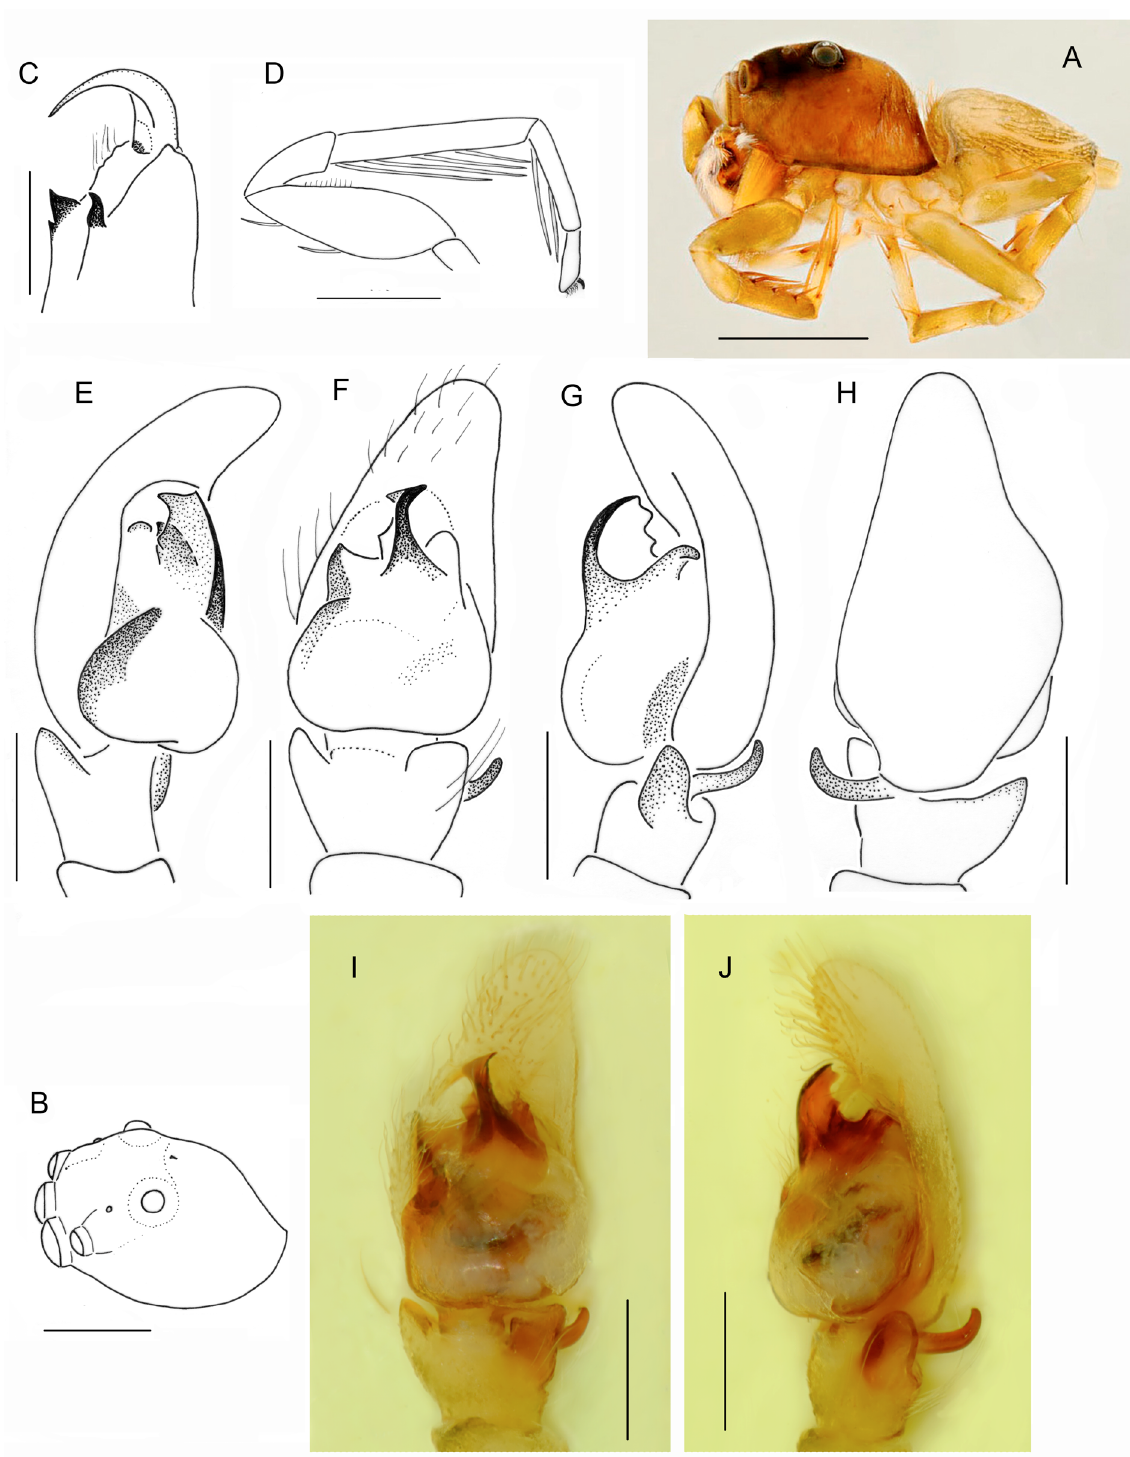
Fig. 9. Pochytoides poissoni (Berland & Millot, 1941) comb. nov., ♂. A . General appearance, lateral view. B . Carapace, dorsolateral view. C . Cheliceral dentition. D . First leg. E–K . Palpal organ. E . Ventroprolateral view. F , I . Ventral view. G , J . Retrolateral view. H . Dorsal view. scale bars: A–B, D = 1.0 mm, C, e–k = 0.3